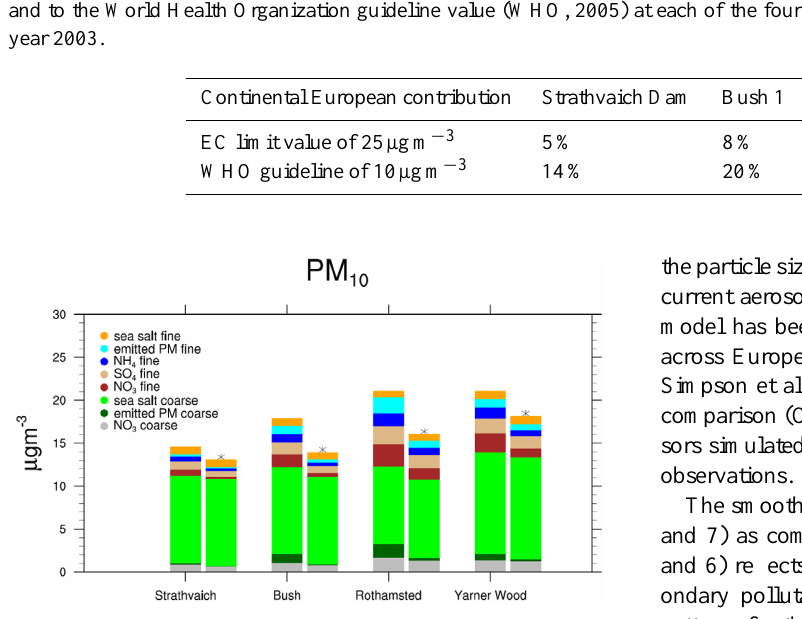
Figure 11. Mean composition of PM 10 components as estimated by the EMEP4UK model for four sites across the UK, averaged for the whole of 2003. The model base run (including all national and international emissions) is compared with the results from a sim- ulation excluding UK emissions (*). The difference in magnitudes between the pairs of adjacent bars indicates the PM derived from emissions within the UK. As well as the SIA components, the total modelled PM 10 includes the contribution from emitted primary fine PM (PM 2 . 5 ) and primary PM coarse (i.e. PM 2 . 5 − 10 ) , and fine and coarse sea